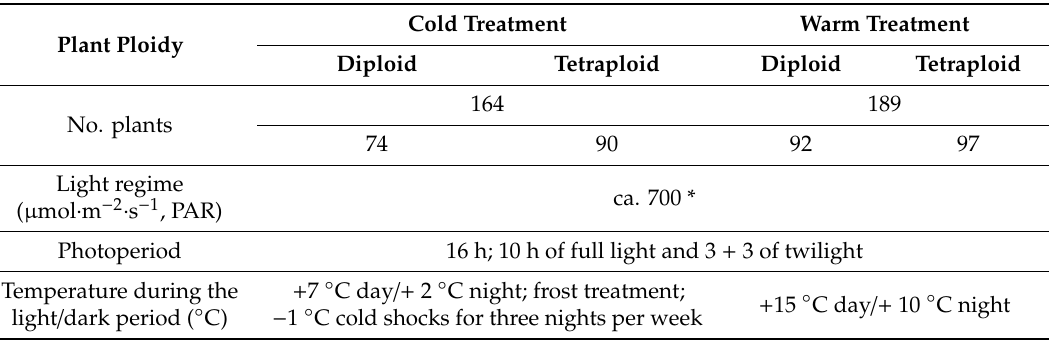
Table 1. Temperature treatment conditions during plant growth and seed formation. Cold Treatment Warm Plant Ploidy